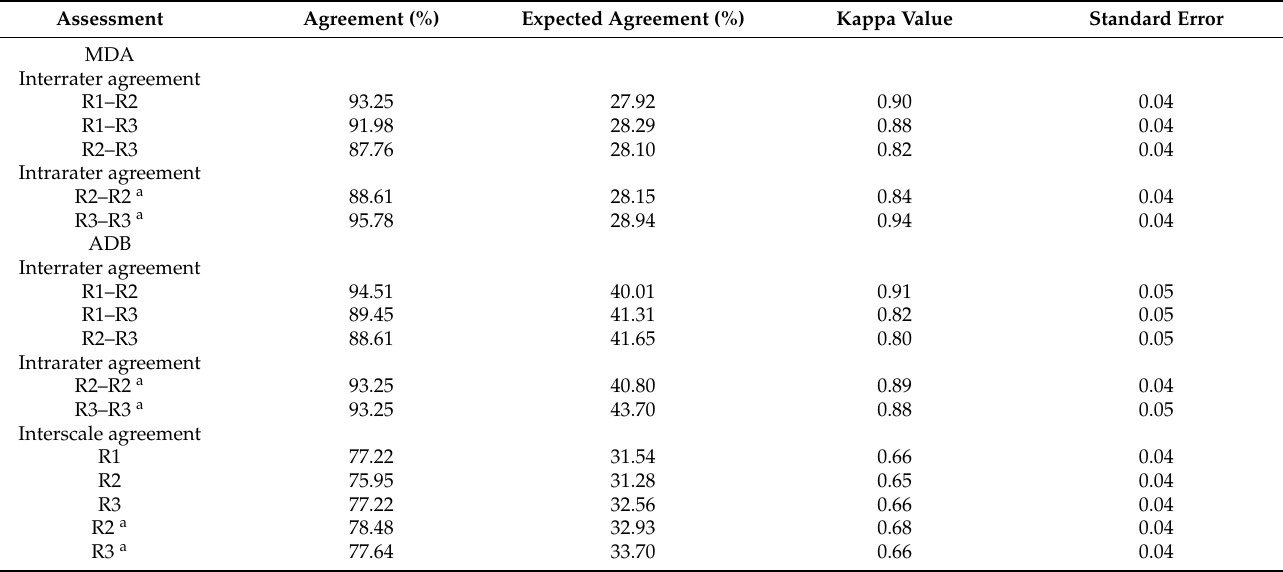
Table 3. This table shows the interrater, intrarater and interscale agreement of the MDA and ADB scale assessments. The interrater agreement shows the agreement between raters. Intrarater agreement shows the agreement within raters. The interscale agreement shows the agreement between the MDA and the ADB scale. Interrater R2 and R3 performed staging blinded to all patient demographics and clinical variables. The second intrarater assessment was performed after a two-month wash-out interval. R1 = rater 1, R2 = rater 2, R3 = rater 3. a = second